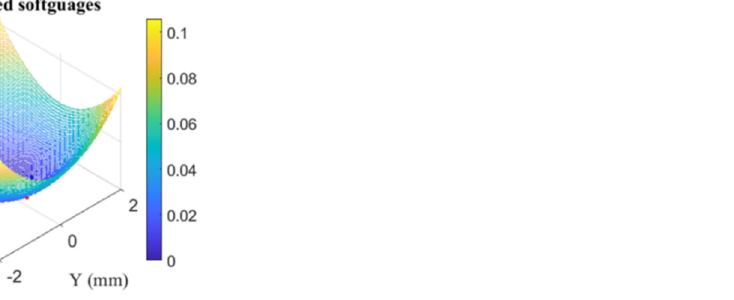
Figure 11. One generated reference softgauges with a non-vertex solution (five contacting points).